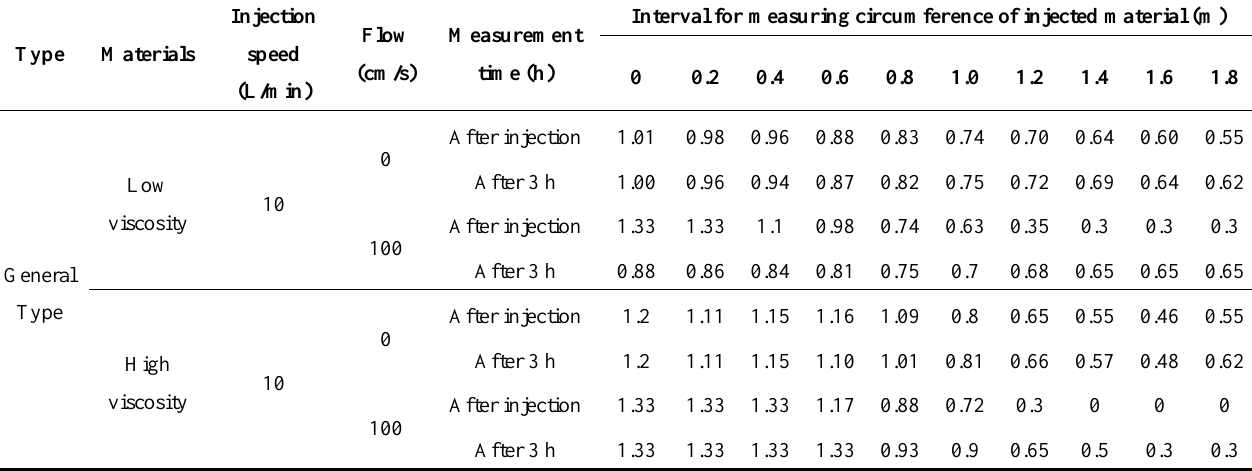
Table 2. Length measured for general type material.